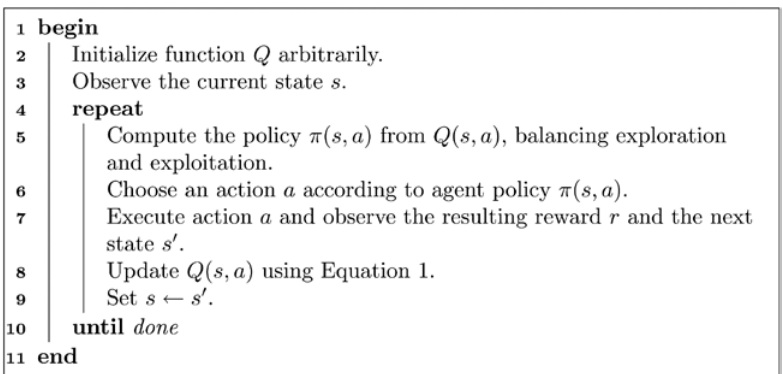
Algorithm 1: Q -learning